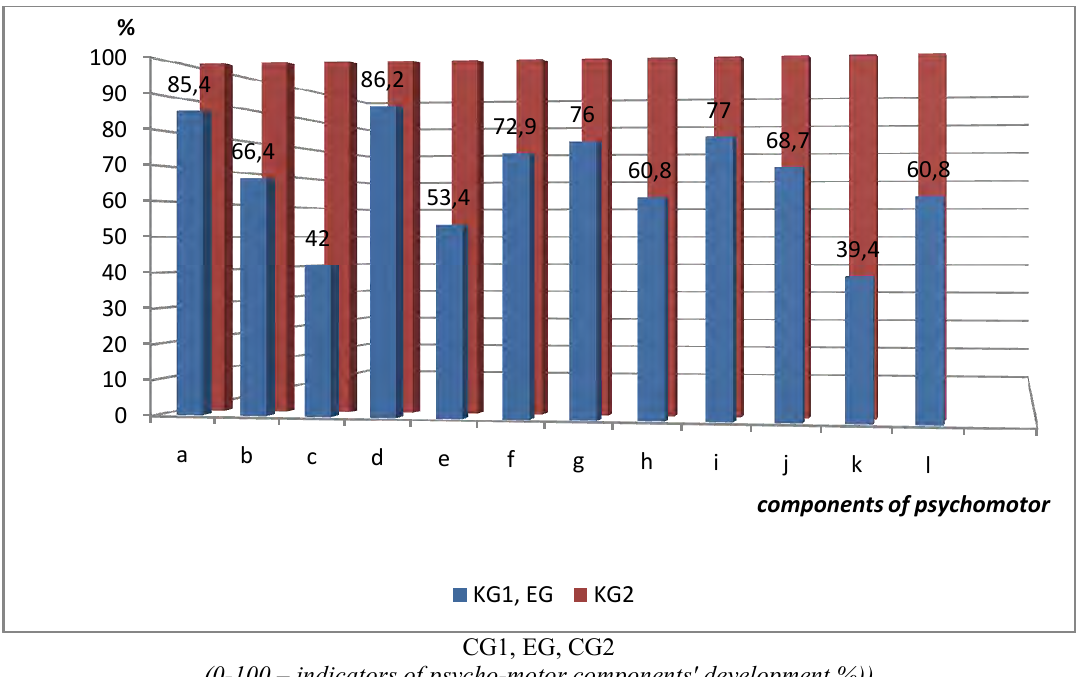
CG1, EG, CG2 (0-100 – indicators of psycho-motor components' development,%)) Fig.1. Difference between indicators of main psycho-motor components of junior school age deaf children (EG and CG1) and their hearing peers